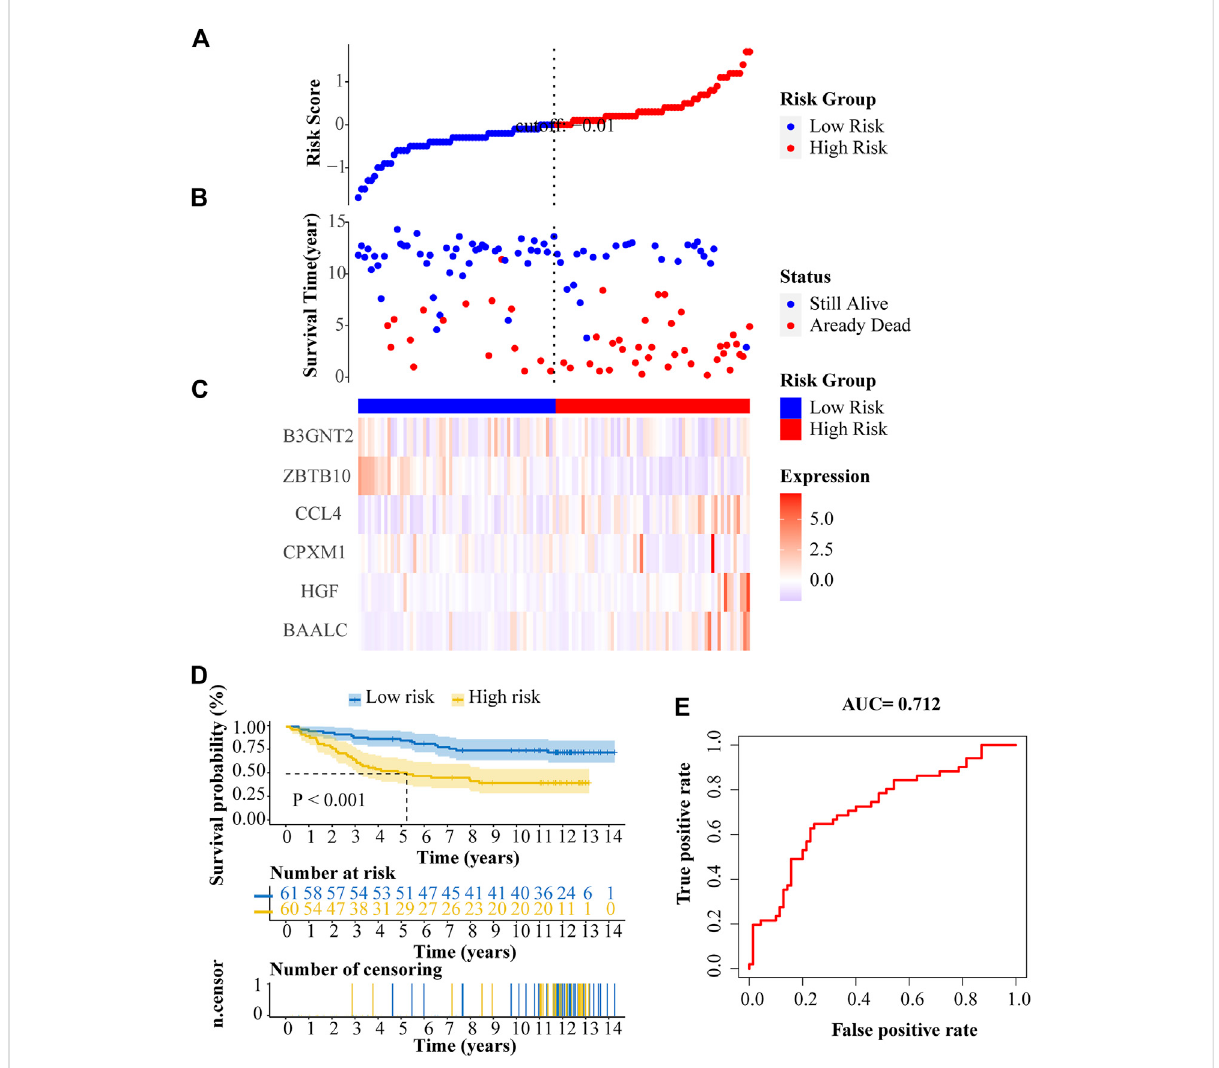
FIGURE 8 External veri fi cation of the prognostic ALL gene signature. (A) Risk scores distribution. (B) Survival status of patients. (C) Heat map of gene expression pattern. (D) Kaplan-Meier plot for overall survival (OS) of patients in different risk groups. (E) ROC curve of risk